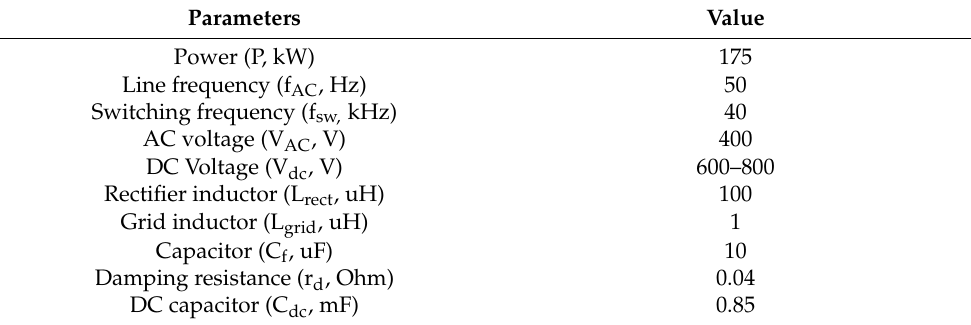
Table 1. Charger